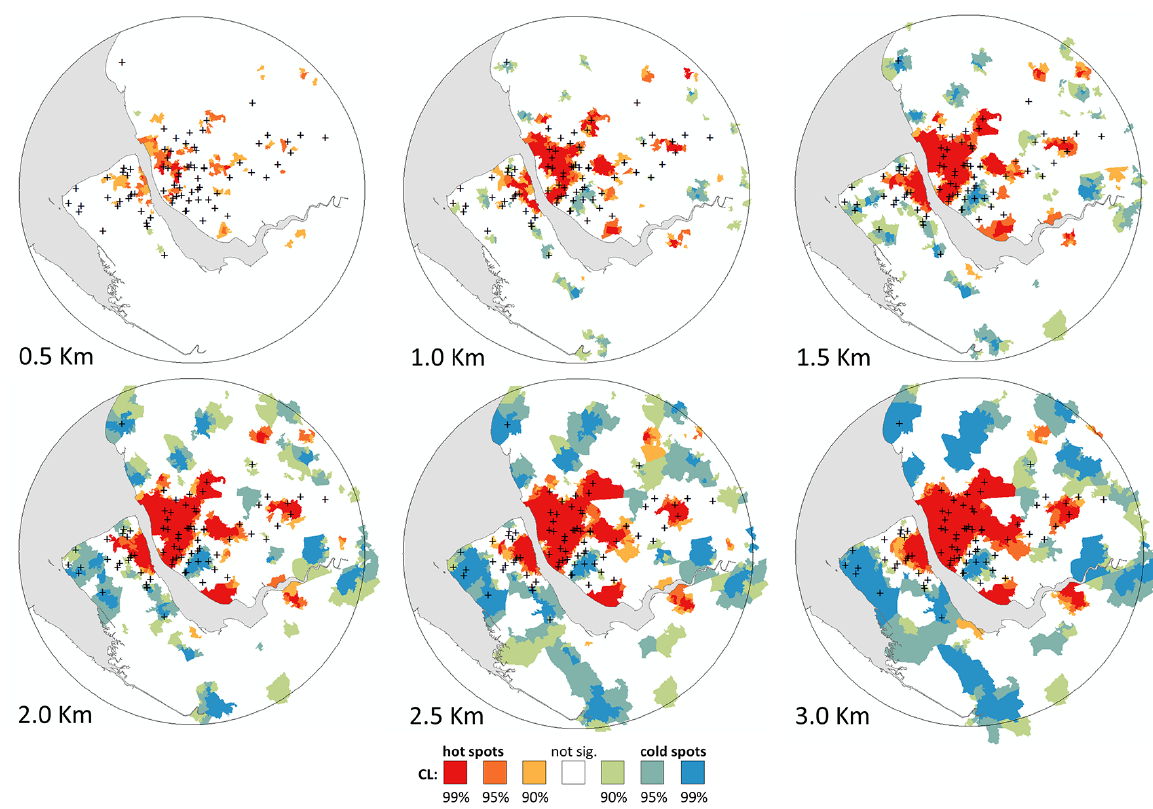
Figure 3. Hot/cold spot analysis of Income scores for the study area.